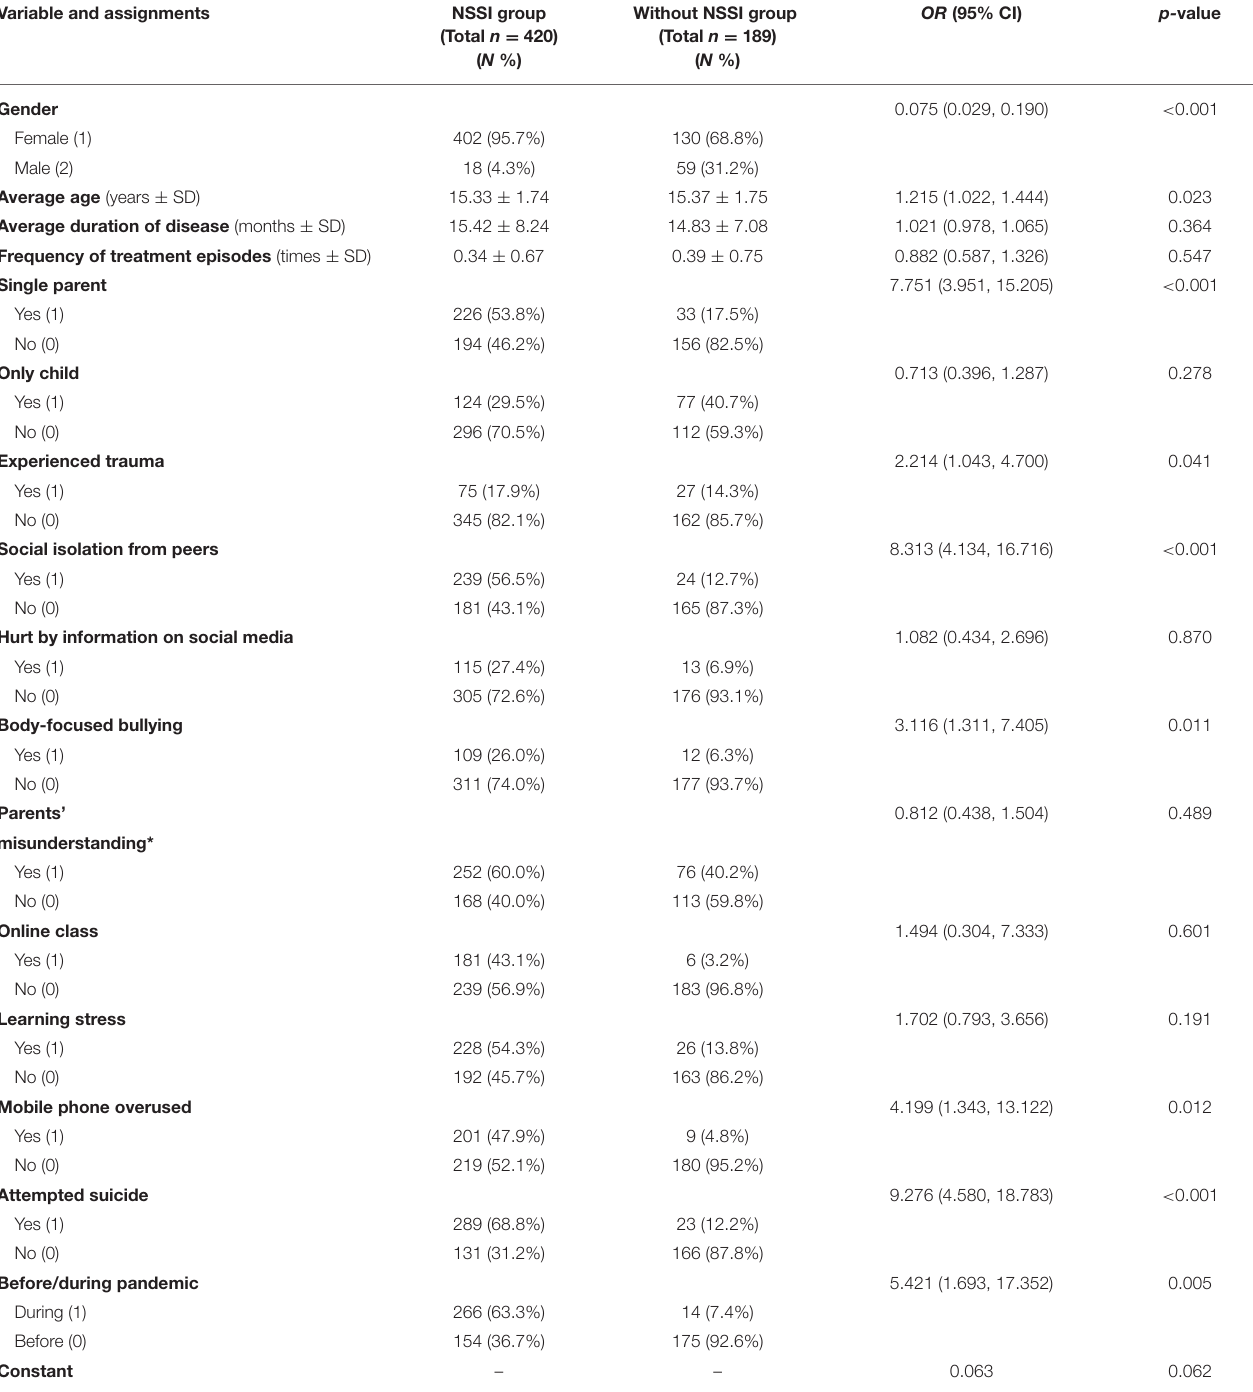
TABLE 1 | The demographic characteristics and psychosocial factors related to NSSI among adolescents admitted to our hospital. Variable and